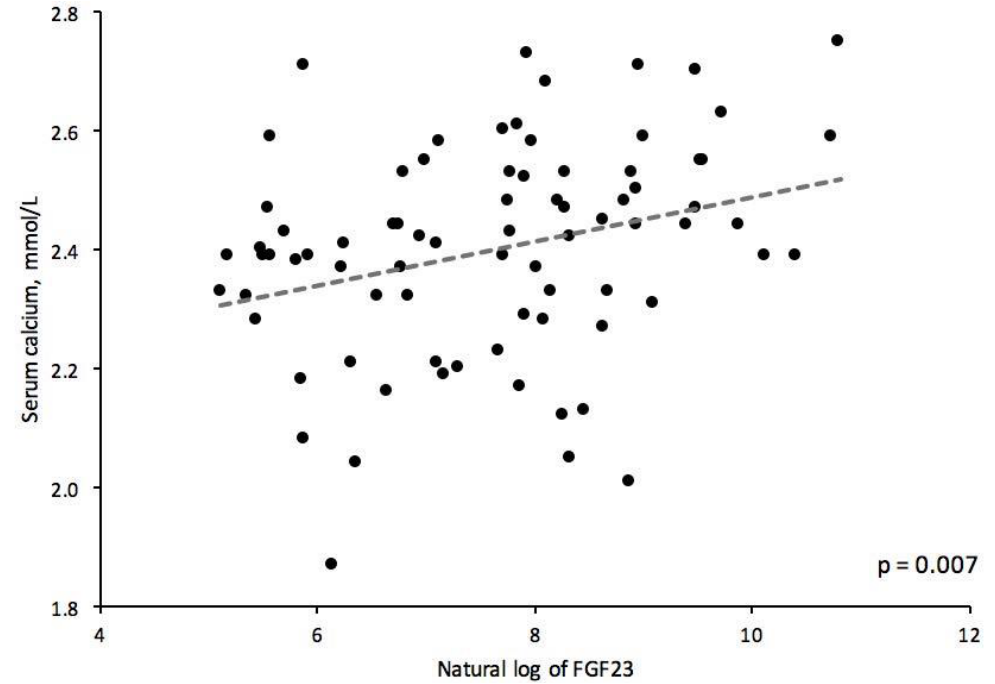
Figure 2. Serum calcium versus the natural log of FGF23.